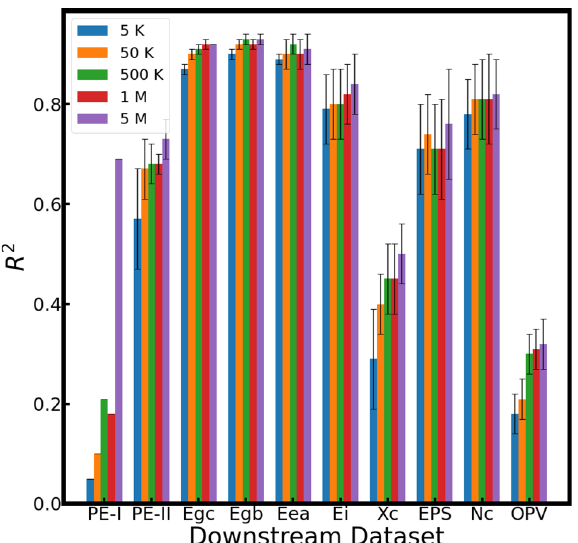
Fig. 4 Model performance with varying pretraining data sizes. The R 2 for each downstream task with different pretraining data sizes are presented in the bar plot. Error bars are included if cross- validation is implemented.